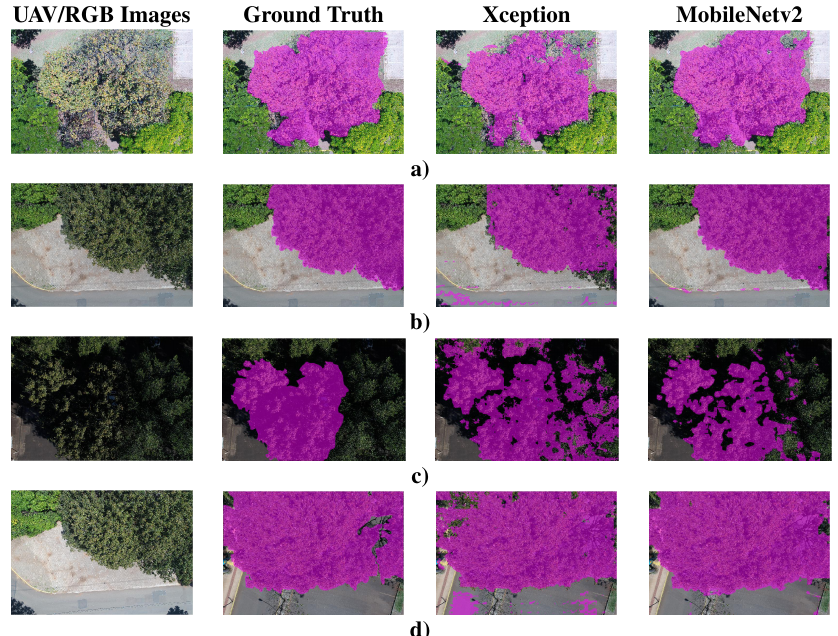
Figure 6. Qualitative results for DeepLabv3+ method using Xception and MobileNetv2